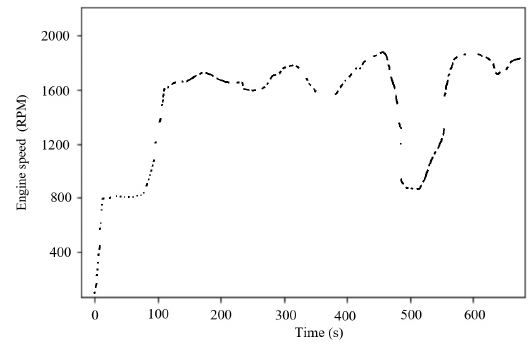
Figure 3. The original data.